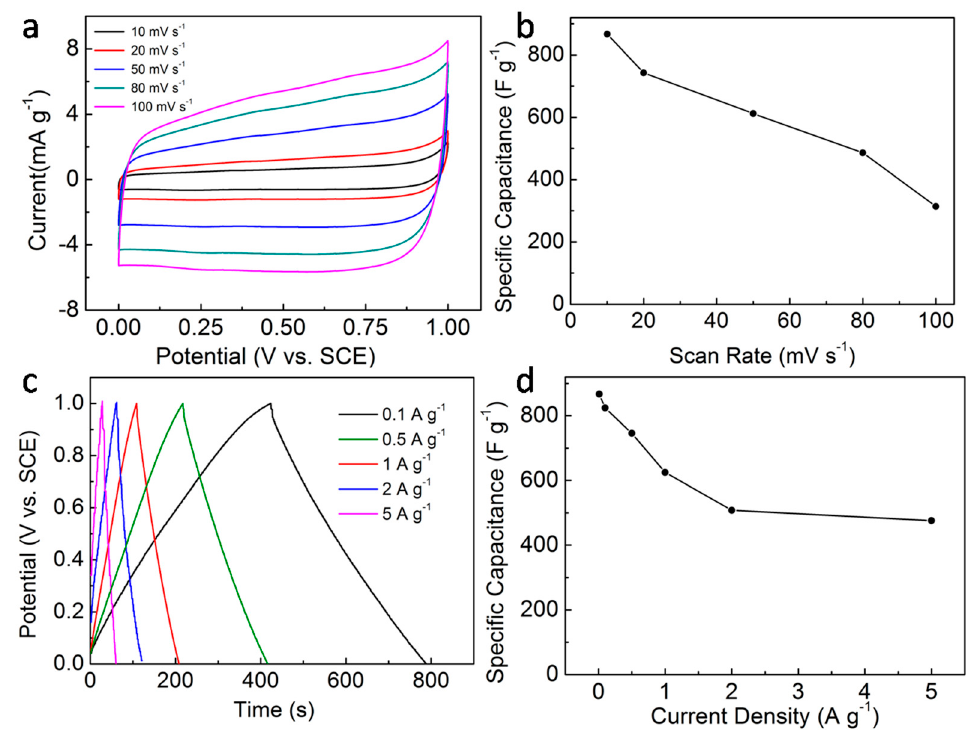
Figure 4. CV curves ( a ), the corresponding specific capacitances at various scan rates ( b ), GCD plots ( c ), the corresponding specific capacitances at various current densities ( d ) of the MnFe 2 O 4 @C electrode.